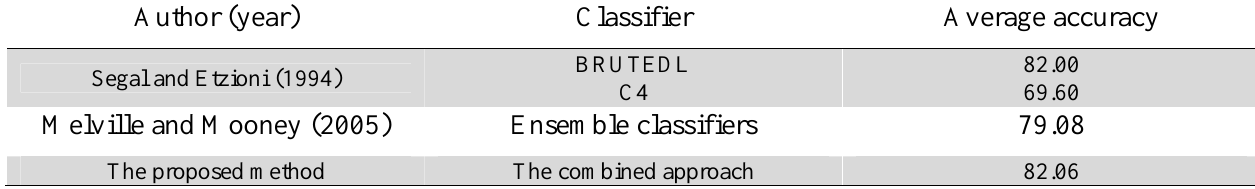
The proposed model in comparison with other classifiers in “Lymphography” dataset